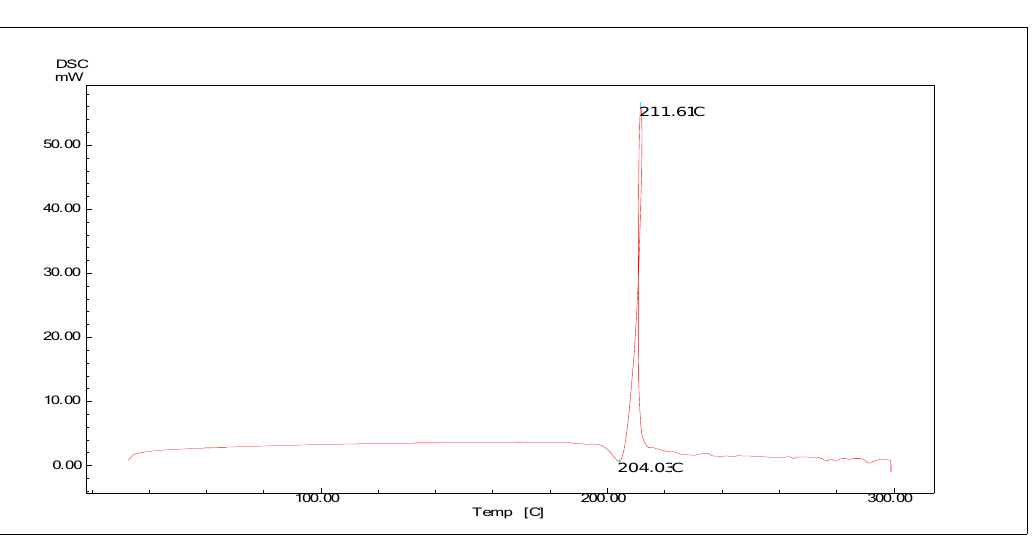
Figure 1. DSC thermogram of